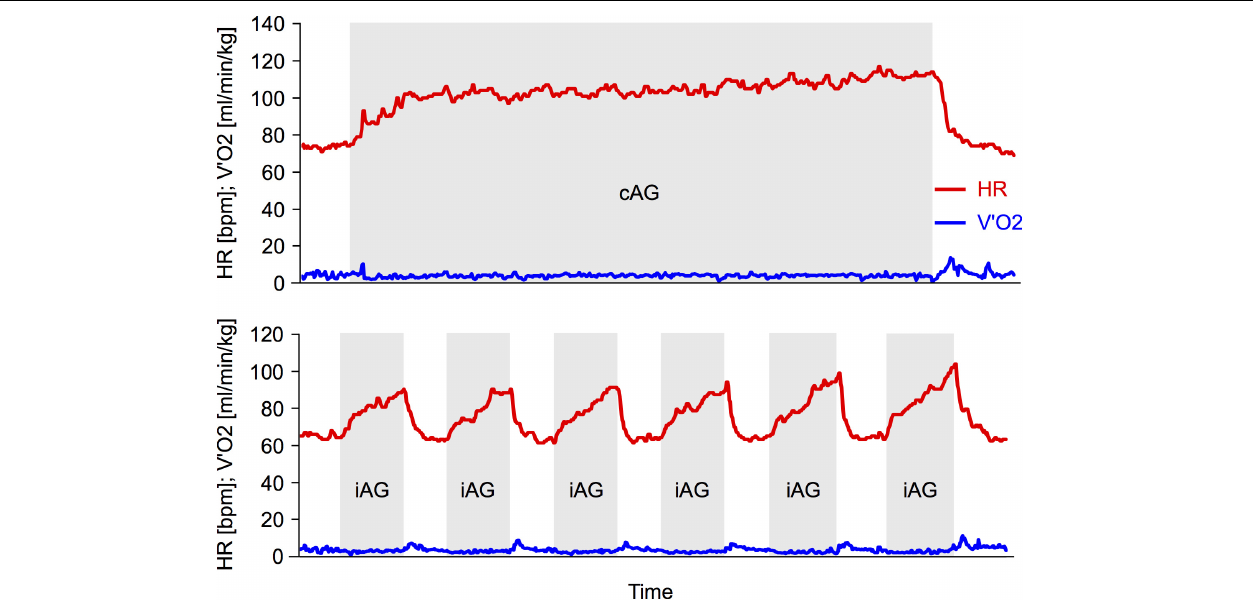
FIGURE 2 | Exemplary data during centrifugation. Top: exemplary data from one session from one participant of the continuous artificial gravity group (cAG). Bottom: exemplary data from one session from one participant of the intermittent artificial gravity group (iAG). Red lines represent the heart rate (HR), blue lines the oxygen consumption (V’O 2 ). The cAG consists of 30 min of continuous centrifugation, whereas the iAG consists of 6 × 5 min of centrifugation (marked in gray), interspersed with breaks of 3